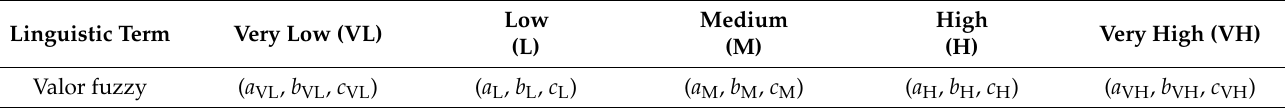
Table 1. Set of linguistic terms used in